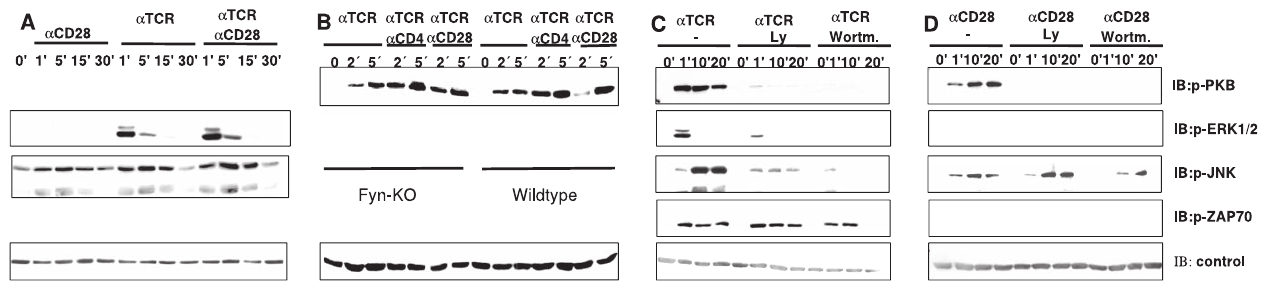
Figure 3. In Vitro Analysis of Model